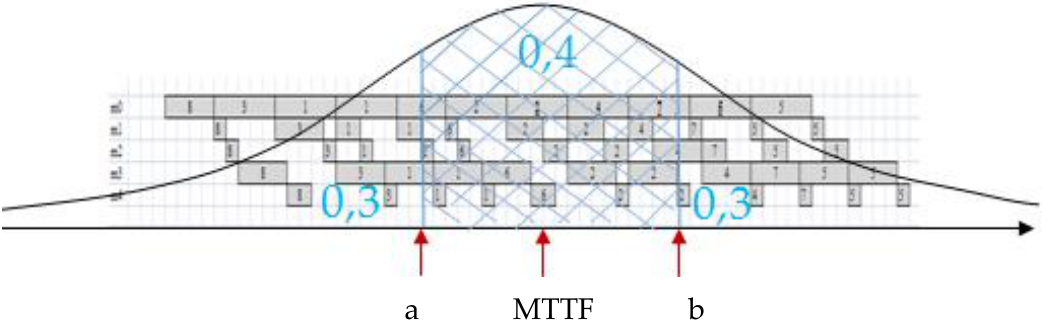
Figure 1. The period of increased risk of failure [ a , b + mean time of repair ( MTTR )] for the truncated normal distribution. 05.0 u